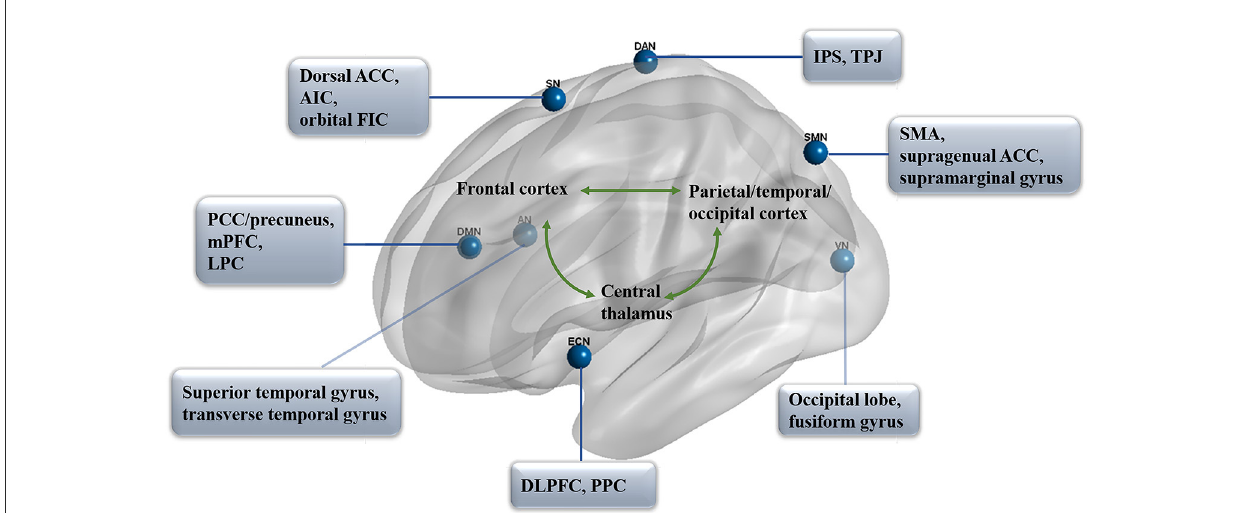
FIGURE1 Functional networks in prolonged DoC. The distribution of seven primary networks that control the resting state of functional connectivity in prolonged DoC. DMN, default mode network; PCC, posterior cingulate cortex; mPFC, medial prefrontal cortex; LPC, lateral parietal cortex; DAN, dorsal attention network; IPS, intraparietal sulcus; TPJ, temporoparietal junction; ECN, executive control network; DLPFC, dorsolateral prefrontal cortex; PPC, posterior parietal cortex; SN, salience network; ACC, anterior cingulate cortex; AIC, anterior insula cortex; FIC, frontoinsular cortices; AN, auditory network; VN, visual network; SMN, sensorimotor network; SMA, supplementary motor